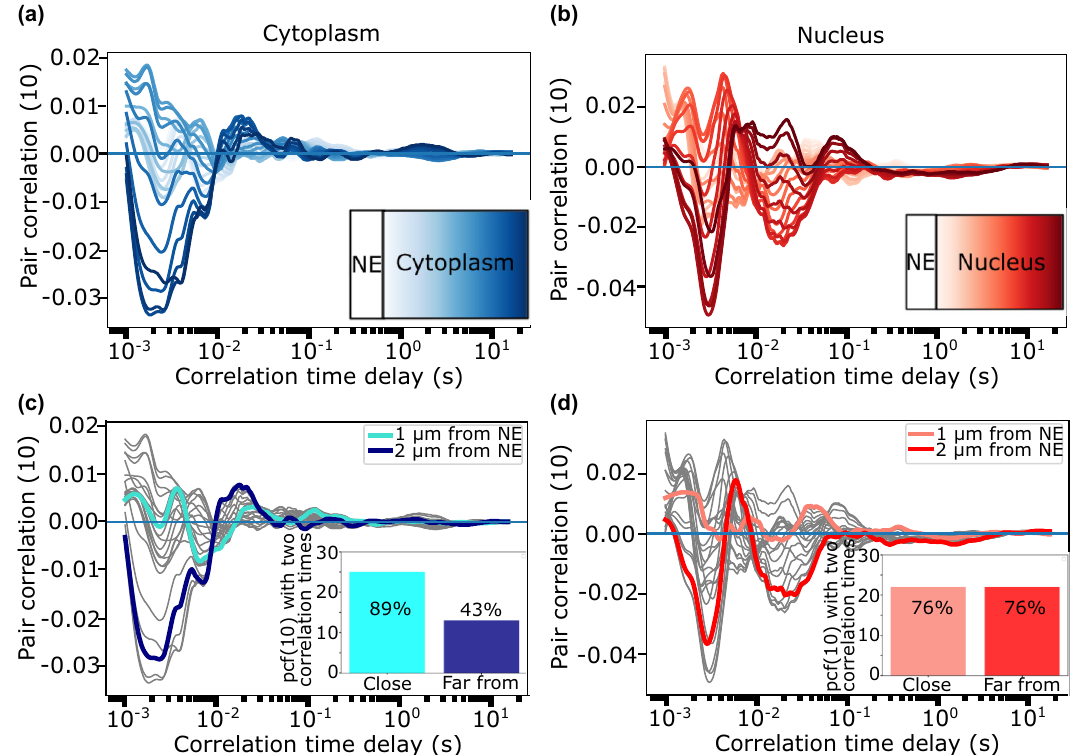
Figure 6. pCF pixel-by-pixel analysis Representative results of a pCF(10) analysis calculated pixel-by-pixel along a scanned confocal line across the cytoplasm (left) and the nucleus (right) of a DENV infected cell. Panels ( A , B ) show pCF(10) curves as a function of the NE distance (the closer to the NE, the lighter the color). Pixels closer to each other (similar shades of blue or red) tend to have similar correlation curves. In panels ( C , D ) pCF(10) curves at 1 and 2 μm from NE are highlighted showing the presence of positive correlation peaks close to the NE (in light color) but the presence of only one positive correlation peak far from the NE (in dark